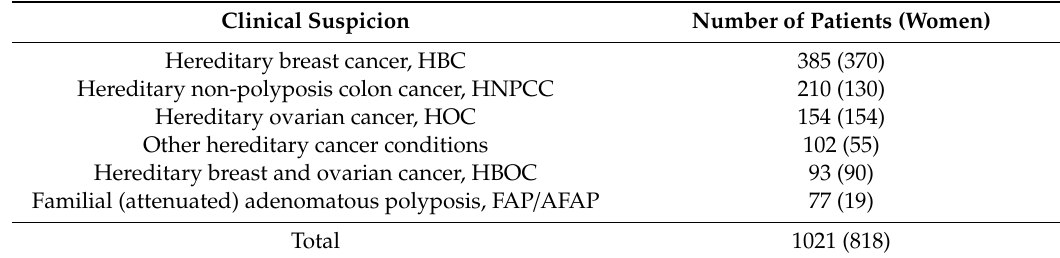
Table 2. Summary of the hereditary cancer cohort by clinical